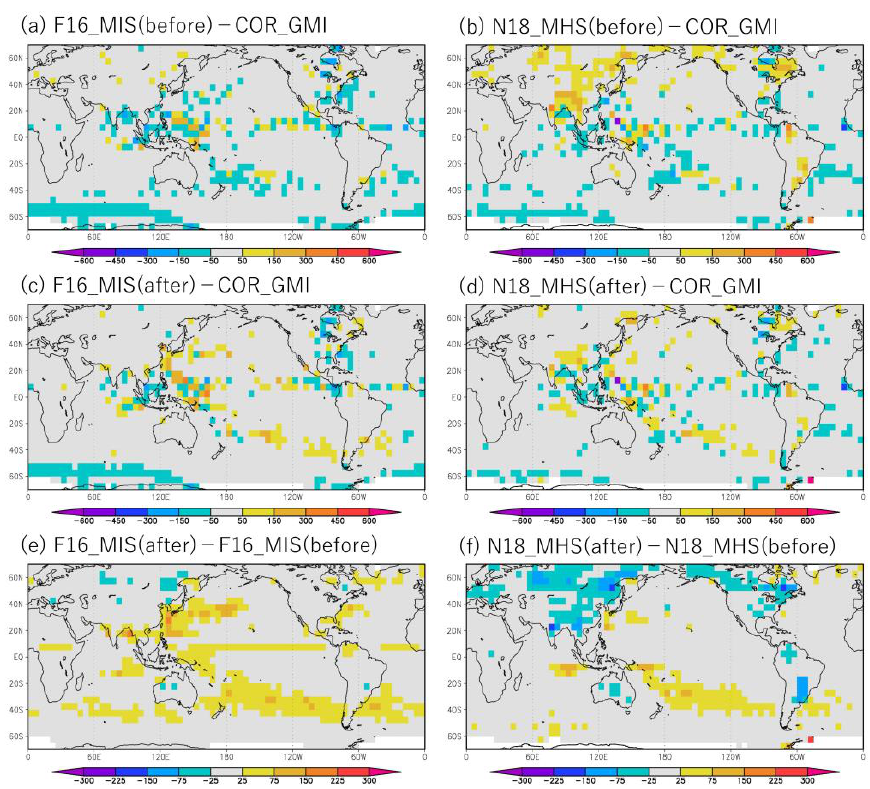
Figure 6. Monthly rainfall difference in July 2014 between ( a ) F16_MIS before MMN correction and COR_GMI, ( c ) F16_MIS after MMN correction and COR_GMI, and ( e ) F16_MIS before and after MMN correction. ( b , d , f ) are the same as ( a , c , e ), except for N18_MHS.